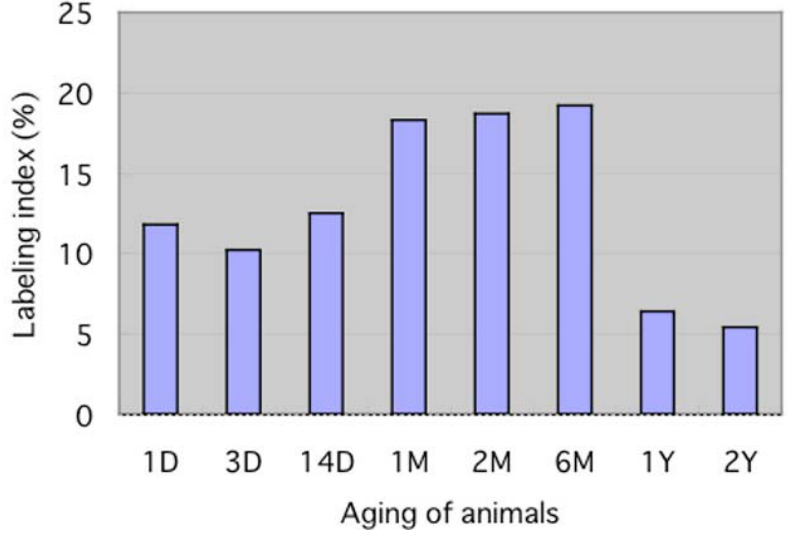
FIGURE 6 . Histogram demonstrating aging change of the labeling index of mitochondria in binucleate hepatocytes labeled with 3 H-leucine, showing protein synthesis (number of labeled mitochondria/number of total mitochondria), at respective aging groups from postnatal day 1 to postnatal month